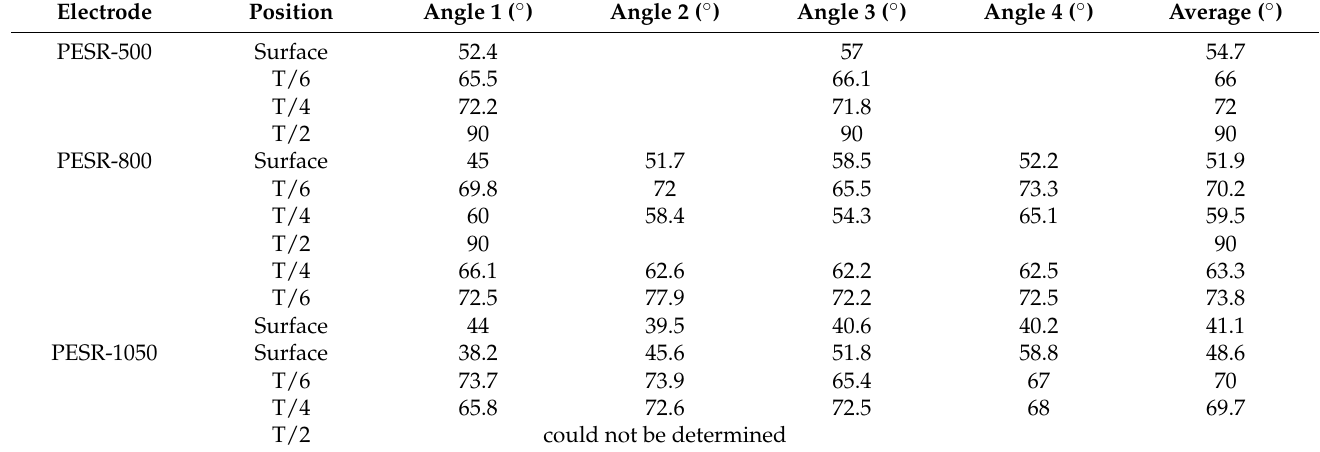
Table 4. Data and statistics for the angle between the dendrite arms and the axial plane. Electrode 300 × 300 mm 2 (CE-300), the electro-slag remelted ingots 400 × 400 mm 2 (ESR-400 1,2), and the pressure electro-slag remelted ingots 500–1050 mm in diameter (PESR-500, PESR-800, and PESR-1050).